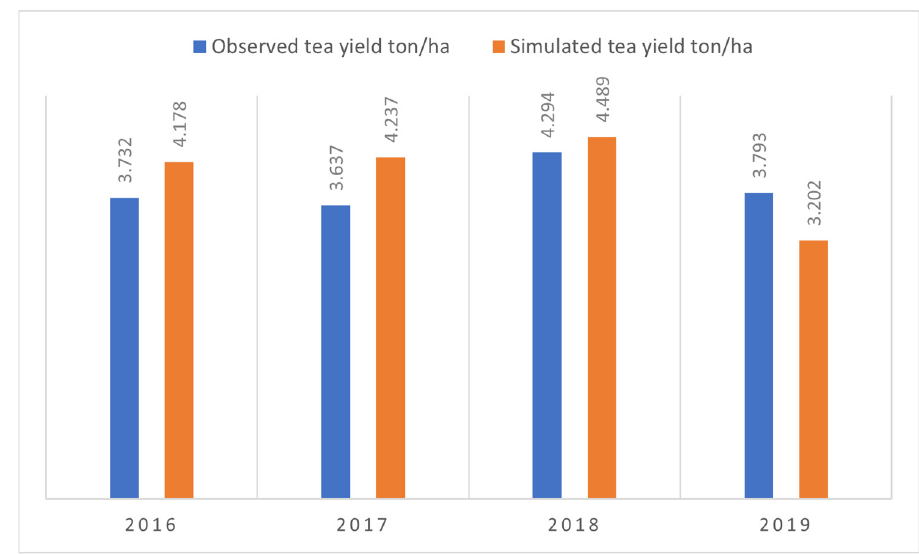
Figure 4. Observed vs. simulated yield for the years 2016–2019.